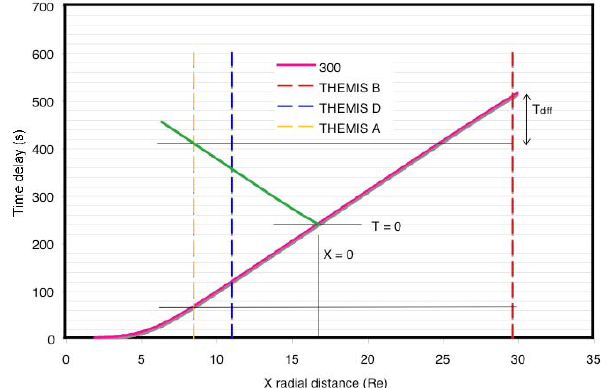
Fig. 5. Illustration of obtaining the X =0 T =0 graphically from the Figure 5. Illustration of obtaining the X=0 T=0 graphically from the difference in arrival difference in arrival times ( T diff ), the x position of the satellites and times (T diff ), the x position of the satellites and the curve representing the integrated the curve representing the integrated reciprocal of the propagation reciprocal of the propagation velocity (using the 300 k/s case) as a function of radial velocity (using the 300k/s case) as a function of radial distance. distance. Figure 5 illustrates another possible graphical method for obtaining a starting location ion acoustic speed = (kT/m) 1 / 2 and V A is the Alfv ´ en (x=0) and time (T=0) from measurements of the time difference of arrival of the magnetic impulse at two satellites with varying propagation velocity. The red curve is a derivative of the propagation speed curve of Figure 4 corresponding to an iono-acoustic speed of 300 km/s. In this plot we have integrated the reciprocal of velocity along the radial distance to produce the time taken by signals propagating along this dimension. In this plot the ordinate represents a linear time dimension where simple linear equations can be solved for obtaining the starting location and time regardless of the intrinsically non-linear nature of the propagation velocity. As an example consider that a substorm was observed by satellite THEMIS A (located at 8.5 R e yellow vertical dashed line) and the signature of the same substorm was picked up at THEMIS B (located at 29.5 R e red vertical dashed line) at T diff later. Assuming that the signature had started at X=0 and T=0 and “propagated along” the red curve left to right to THEMIS B. We can subtract T diff from the ordinate value at THEMIS B and draw a